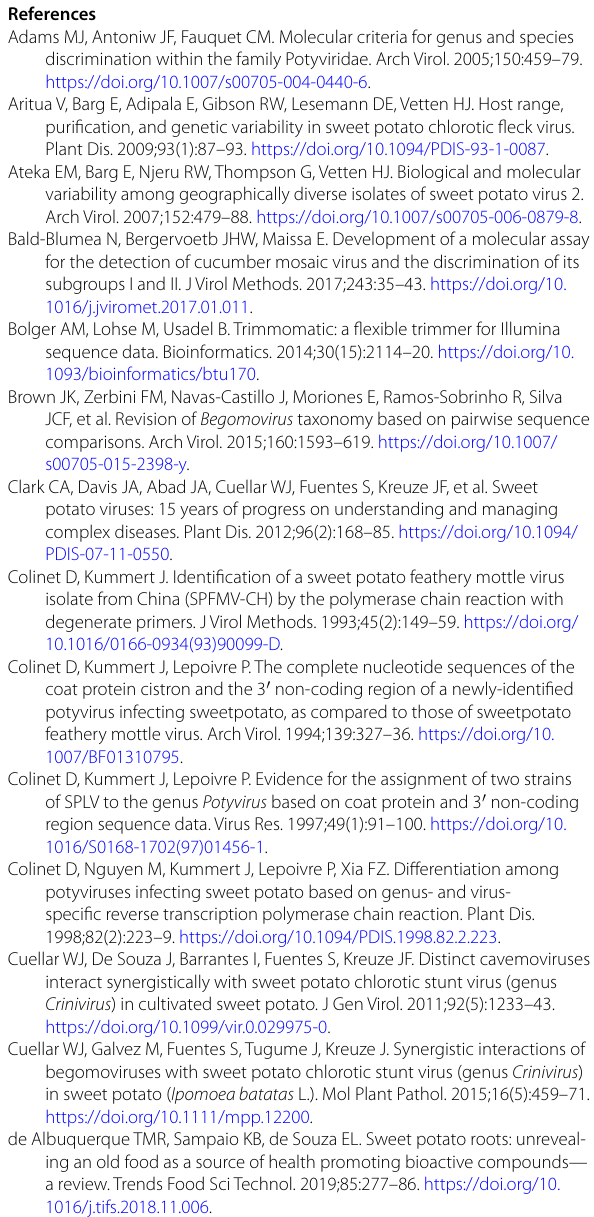
Additional file 1 : Table S1 . Virus species detected in sweet potato fields in different provinces. Table S2 . Virus isolates obtained in the present study. Table S3 . Reference sequences used in the present study. Table S4 . SDT analysis of sweepoviruses. Table S5 . SDT analysis of SPLCHbV. Table S6 . SDT analysis of SPLCGV. Table S7 . SDT analysis of SPLCV. Table S8 . SDT analysis of SPSMV-1. Table S9 Viruses detected from 64 samples by next-generation sequencing. Table S10 . Primers used for virus detection in the present study. Table S11 . Primers used for complete genome amplification in the present study. Additional file 2 : Figure S1 . Phylogenetic tree reconstructed using the polyprotein nucleotide sequences of the SPFMV isolates. The tree was generated using MEGA X (MUSCLE alignment, neighbor-joining and p-distance model, and 1000 bootstrap replicates). Sweet potato mild mottle virus (SPMMV) (Z73124) was used as an outgroup taxon. Figure S2 . Phylogenetic trees reconstructed using the polyprotein nucleotide sequences of the SPVG isolates. The tree was generated using MEGA X (MUSCLE alignment, neighbor-joining and p-distance model, and 1000 bootstrap replicates). Sweet potato mild mottle virus (SPMMV) (Z73124) was used as an outgroup taxon. Figure S3 . Phylogenetic tree illustrating the relationship among 9 SPLCHbV sequences. The tree was generated using MEGA X (MUSCLE alignment, neighbor-joining and p-distance model, and 1000 bootstrap replicates). Figure S4 . Phylogenetic tree illus- trating the relationship among 8 SPLCGV sequences. The tree was gener- ated using MEGA X (MUSCLE alignment, neighbor-joining and p-distance model, and 1000 bootstrap replicates). Figure S5 . Phylogenetic tree based on the nucleotide sequences of CP of CMV isolates. The tree was gener- ated using MEGA X (MUSCLE alignment, neighbor-joining and p-distance model, and 1000 bootstrap replicates). Peanut stunt virus (PSV) (U15730) was used as an outgroup taxon. Figure S6 . Phylogenetic tree constructed using near complete genome sequences of SPCFV isolates. The tree was generated using MEGA X (MUSCLE alignment, neighbor-joining and p-distance model, and 1000 bootstrap replicates). Garlic latent virus (GLV) (NC_003557) was used as an outgroup taxon. Figure S7 . Phylogenetic tree constructed using the complete genome sequences of SPSMV-1 isolates. The tree was generated using MEGA X (MUSCLE alignment, neighbor-joining and p-distance model, and 1000 bootstrap replicates). Maize streak virus (MSV) (HQ693373) was used as an outgroup